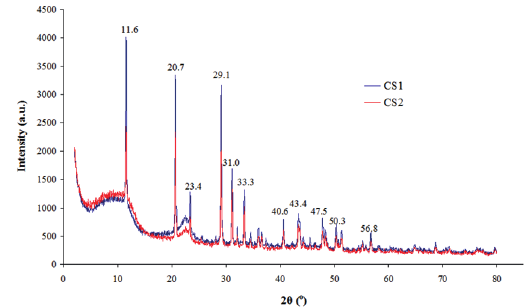
Figure 4: XRD patterns of the two studied samples.